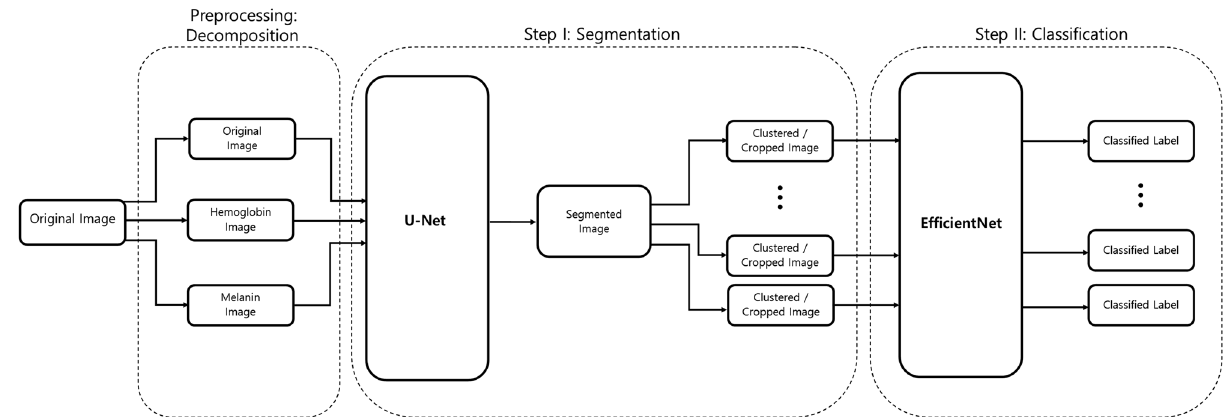
Figure 5. Two-phase analysis model. The original image primarily enters a preprocessing stage, where normalization and decomposition occur. Afterwards, the first step is segmentation, where cluster of abnormal skin are segmented and cropped. The second step is classification, where each cluster is classified into its corresponding class.